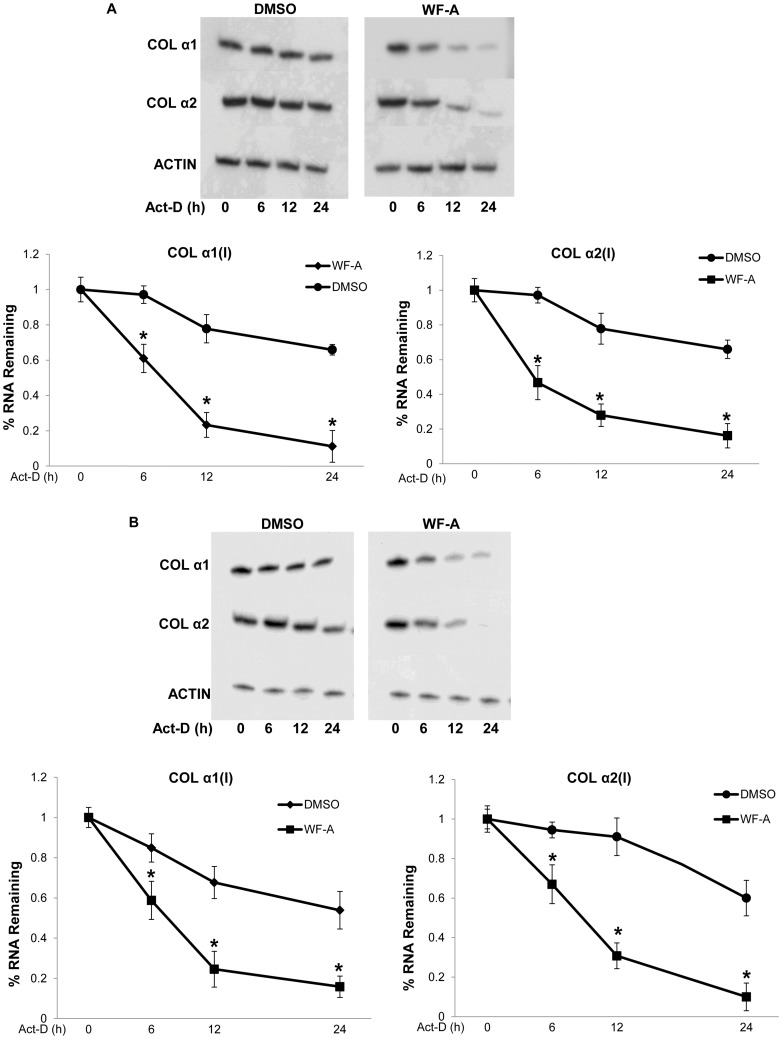
WF-A destabilizes collagen α1(I) and α2(I) mRNAs in human fibroblasts.A. Stability of type I collagen mRNAs in WF-A treated HLF. HLF treated with DMSO (upper left panel) or 1.5 µM WF-A (upper right panel) for 24 h, transcription was blocked with Act D and collagen α1(I) and α2(I) mRNAs were measured by RT-PCR at the indicated times after the transcription block. Actin mRNA was measured as a loading control. Bottom panels: decay rates of collagen α1(I) and α2(I) mRNAs were estimated in DMSO and WF-A treated cells in three independent experiments. Expression of collagen mRNAs was normalized to the expression of actin mRNA and plotted as function of time after the transcription block. The levels at time 0 were arbitrarily set as 1. Error bars represent ±1SEM. B. Stability of collagen mRNAs in WF-A treated SCL fibroblasts. The experiments as in A, except SCL fibroblasts were used. * represents p<0.05.